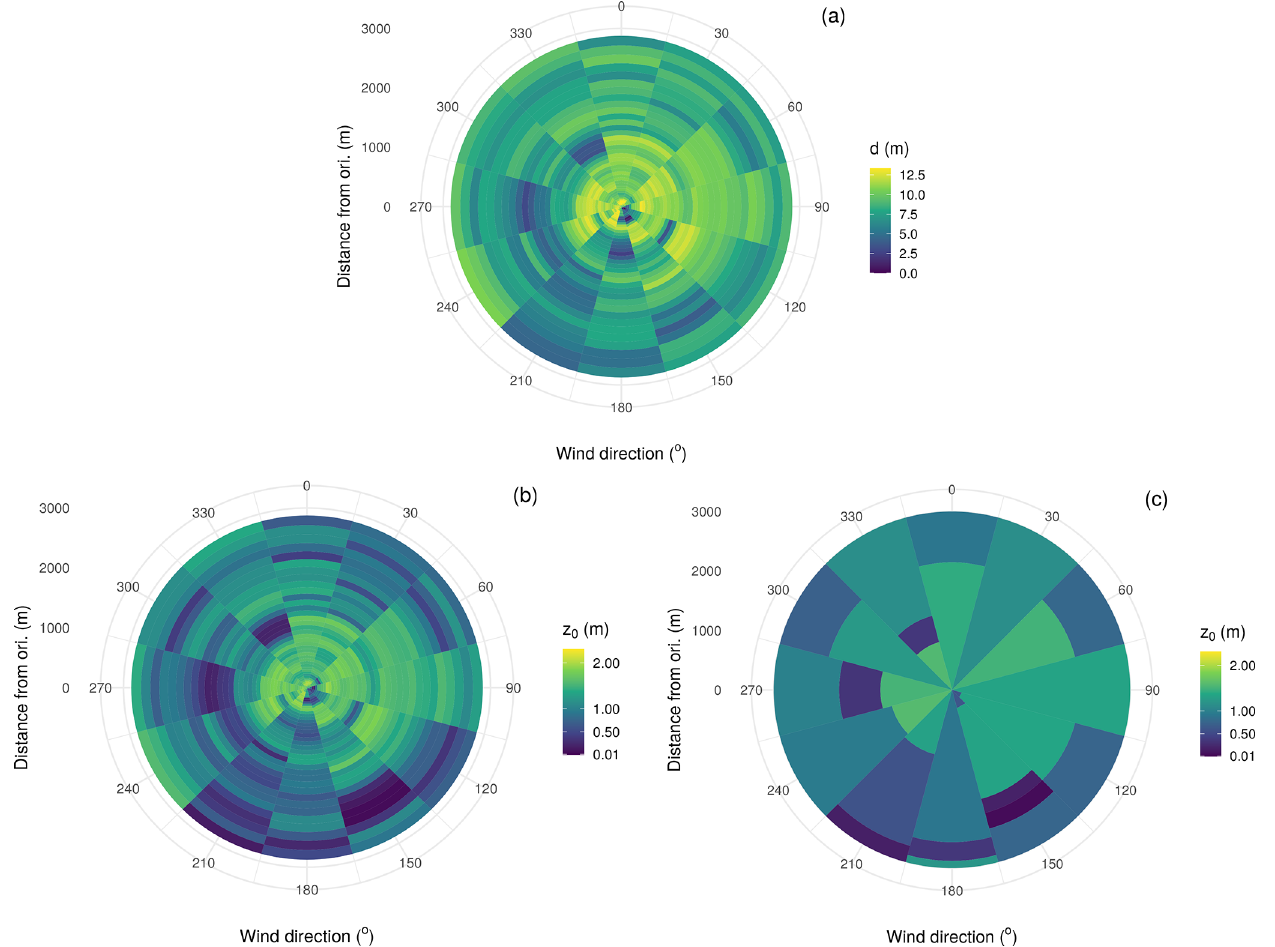
Figure 2. Example of a zooming grid analysis at the Ryningsnäs site up to 3km distance showing the displacement height h (a) , the roughness length z 0 (b) , and the corresponding reduced z 0 rose (c) after finding the most significant z 0